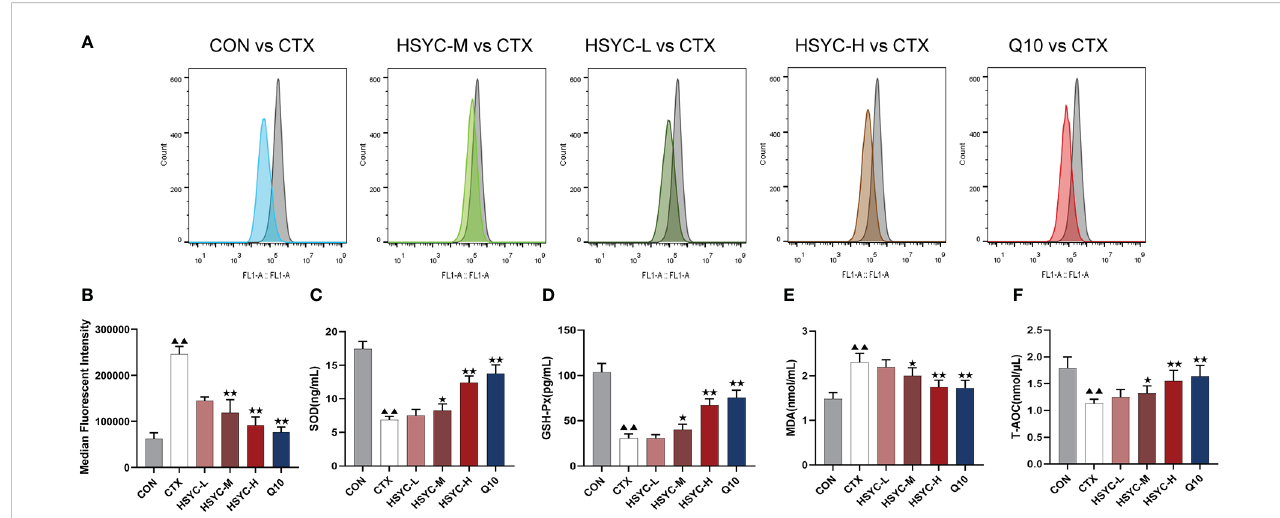
FIGURE 3 HSYC decreased oxidative stress of POI af fl icted mice. (A) Flow cytometric analysis of ROS accumulation in ovarian granulosa cells of different groups, and histogram plots represents means with SD of median fl uorescence intensity (B) . (C-F) the levels of serum superoxide dismutase, glutathione peroxidase, malondialdehyde and total antioxidant capacity of mice in different groups. Histogram elements represent the mean ± SD (n=6). ▲▲ presents P< 0.01 compared to the CON group; ★ presents P < 0.05 compared to the CTX group; ★★ presents P<0.01 compared to the CTX group. SOD, superoxide dismutase; GSH-Px, glutathione peroxidase; MDA, malondialdehyde; T-AOC, total antioxidant